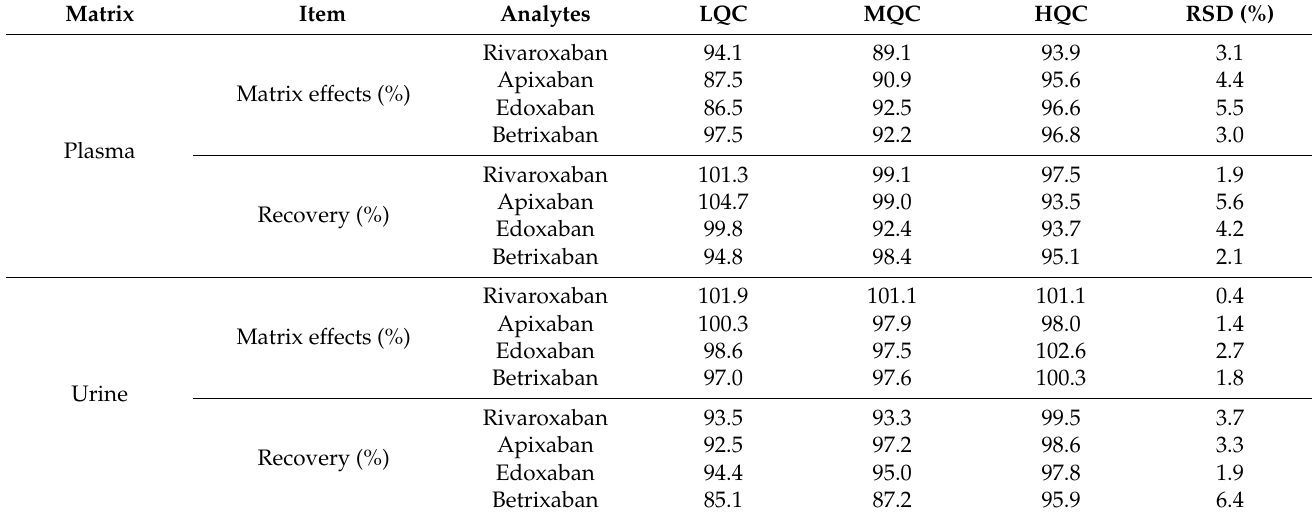
Table 4. The matrix effects and recovery of all